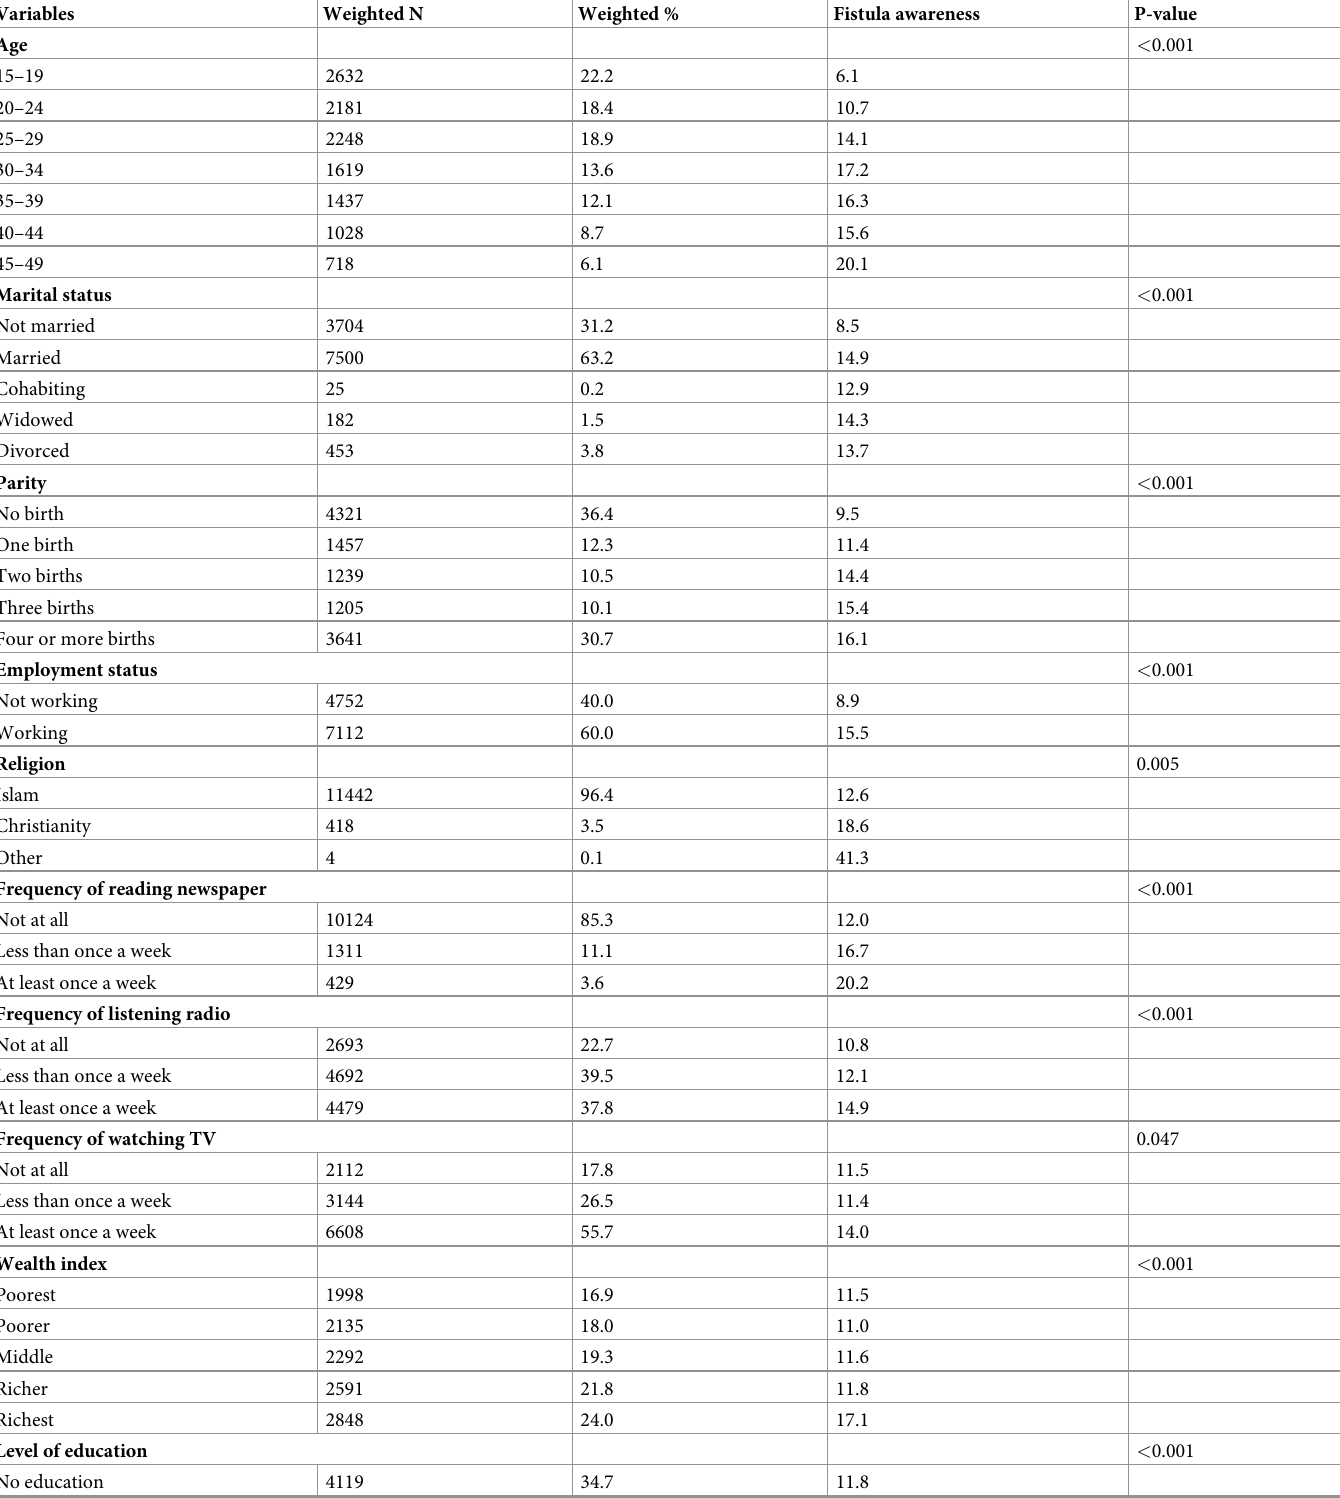
Table 1. Distribution of fistula awareness among women in Gambia (N =